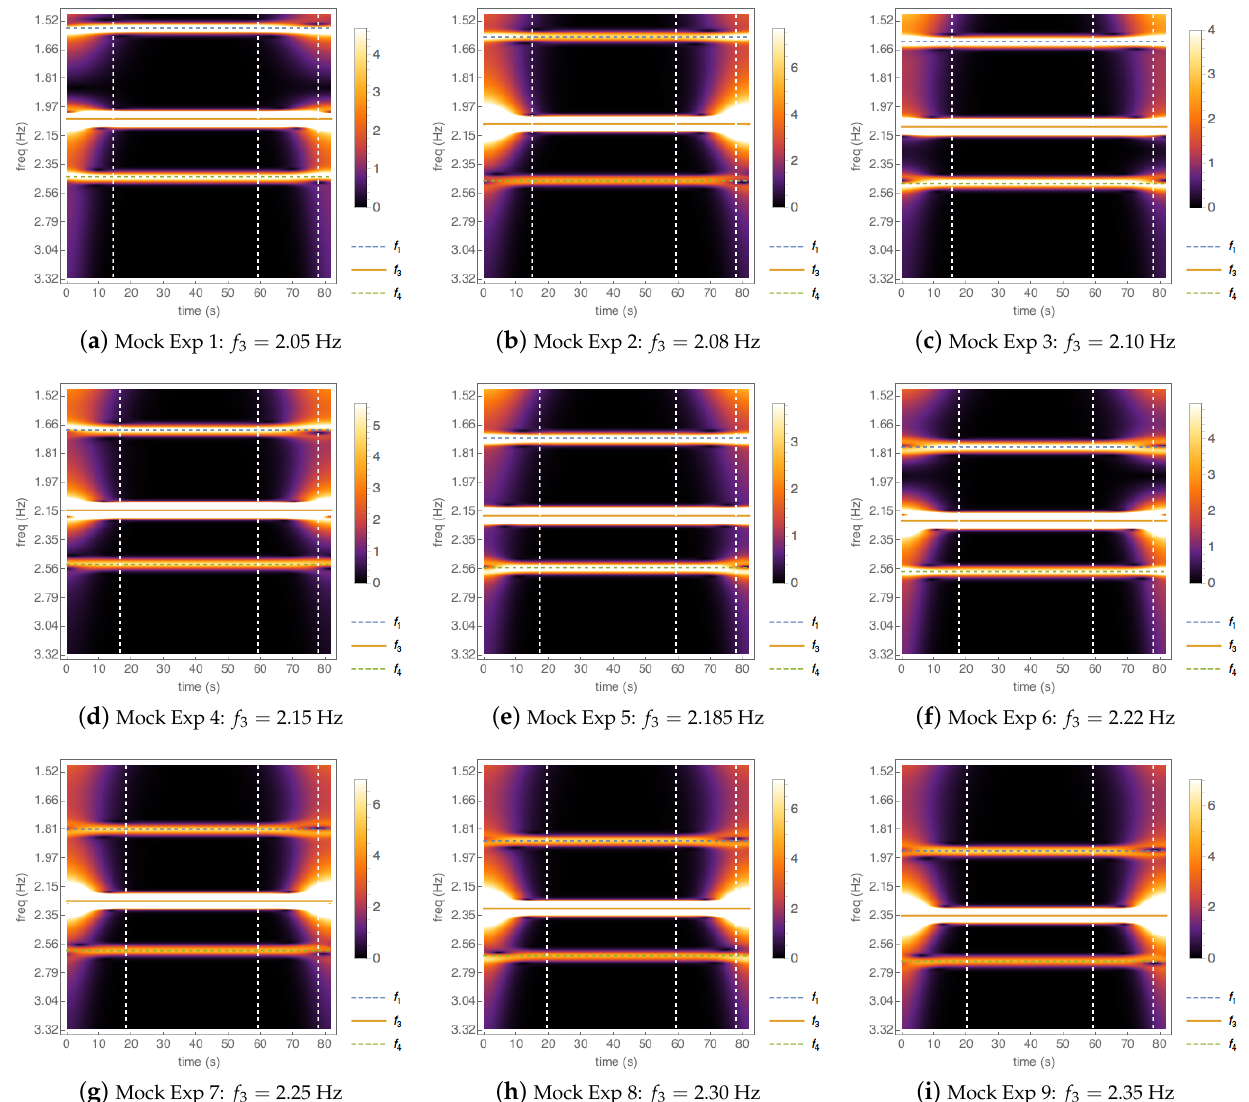
Figure 14. Scaleograms for the artificial signal, Equation (29), mimicking three of the main frequencies found in the experiments: f 1 , f 3 , f 4 . The width about the frequencies f 1 and f 4 is of the order ∆ f = 0.09 f and is due to the way the scaleogram is produced. The following comments apply to all scaleogram figures in this section. The colormaps indicate the amplitude of the scaleograms. The scaleograms are produced by sampling the artificial signal using 4096 time points and performing a continuous wavelet transform using Gabor wavelets with 96 oscillations, with a scale resolution of 11 frequency scales along with 256 voices per